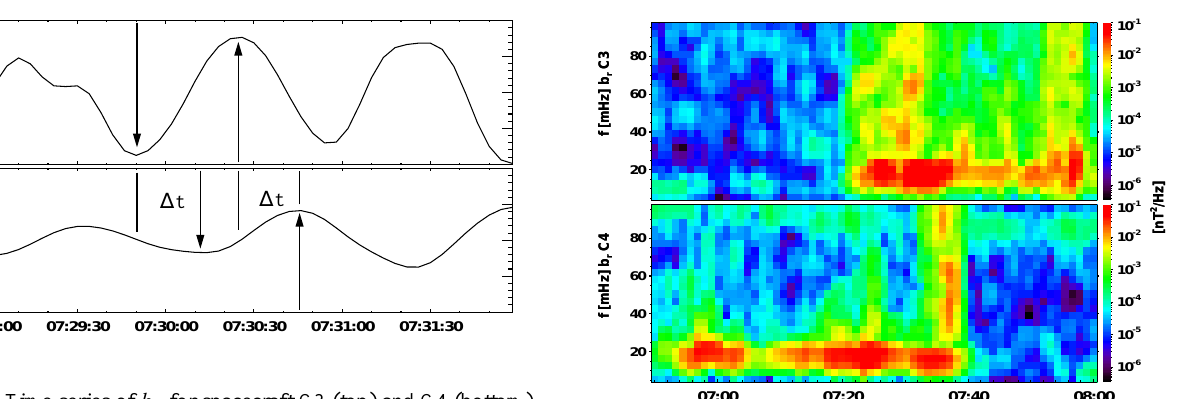
Fig. 7. Time series of b r for spacecraft C3 (top) and C4 (bottom) between 07:29 and 07:32 UT, where both satellites cross the same L-shell at different azimuthal positions M.